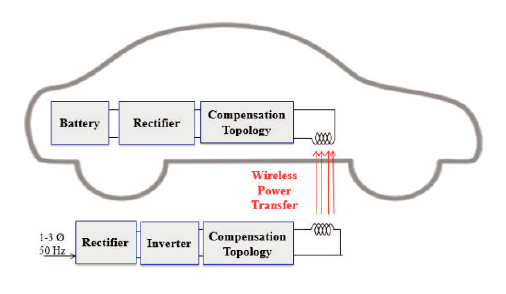
Fig. 1. Structure of a unidirectional wireless charger.